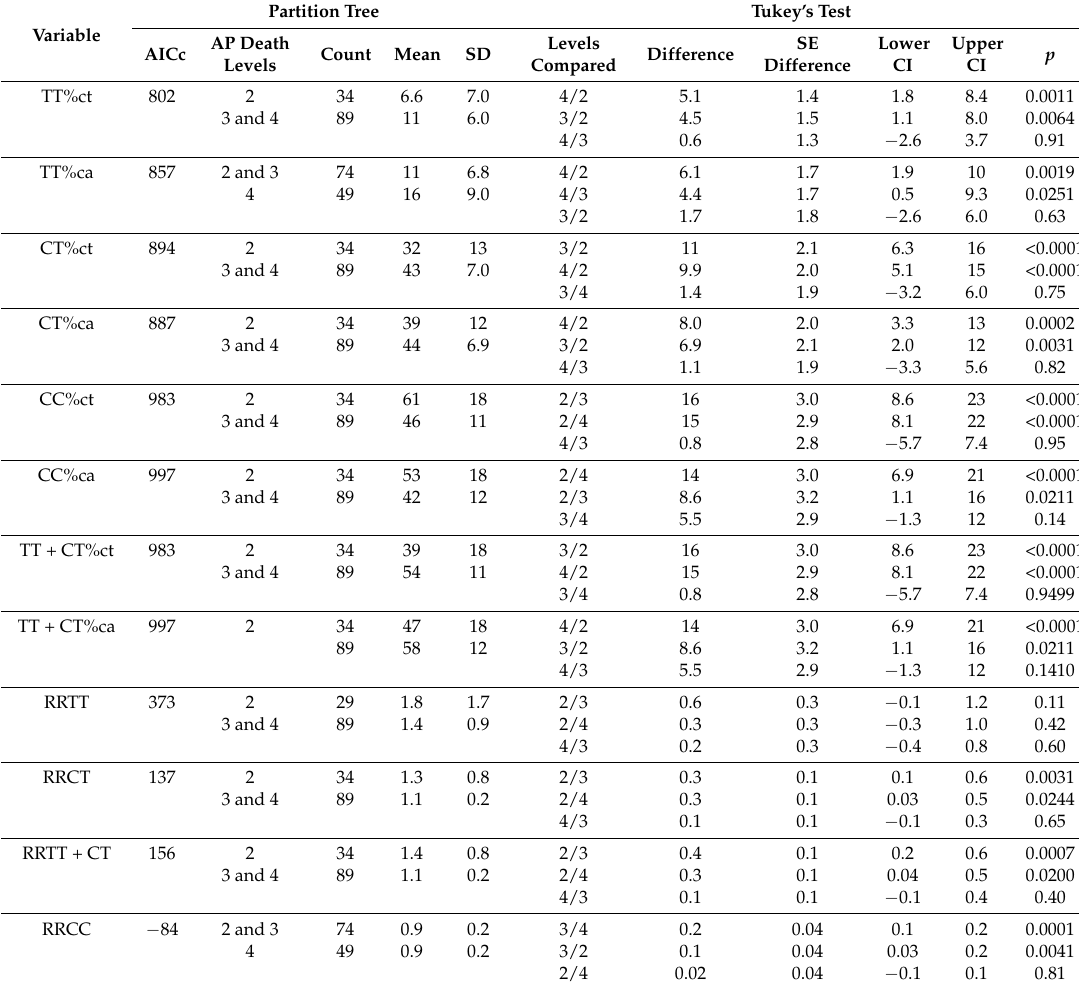
Table 3. Meta-prediction: Death from air pollution (AP death) on percentages of MTHFR 677 genotypes for control (Ct) and ischemic heart disease (IHD) cases (Ca) and IHD